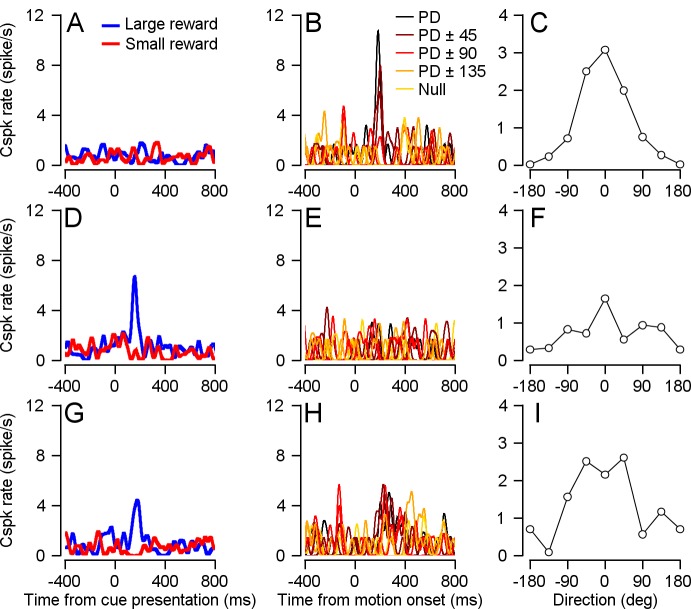
Examples of cells Cspk responses to cue and target movement.(A, D and G) PSTH following cue presentation. (B, E and H) PSTH following target movement onset in the different directions relative to the preferred direction of the cell. (C, F and I): Tuning curve 100–300 ms after target motion onset aligned to the PD of the cell. (A–C) Responses of the example cell in Figure 4. (D–F), Responses of the cell in Figure 2. (G–I) An additional cell.